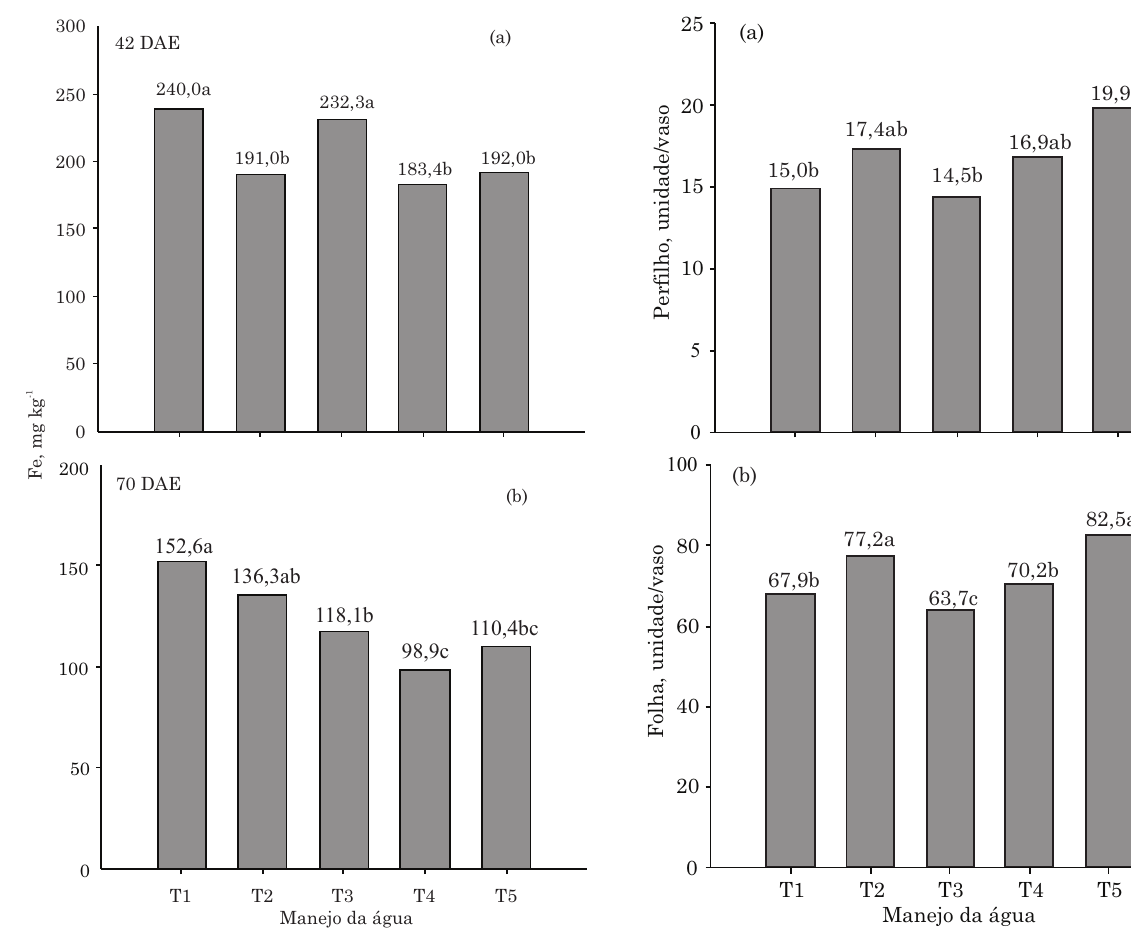
Figura 3. Número de perfilhos (a) e folhas (b) de plantas de arroz aos 70 dias, após a emergência